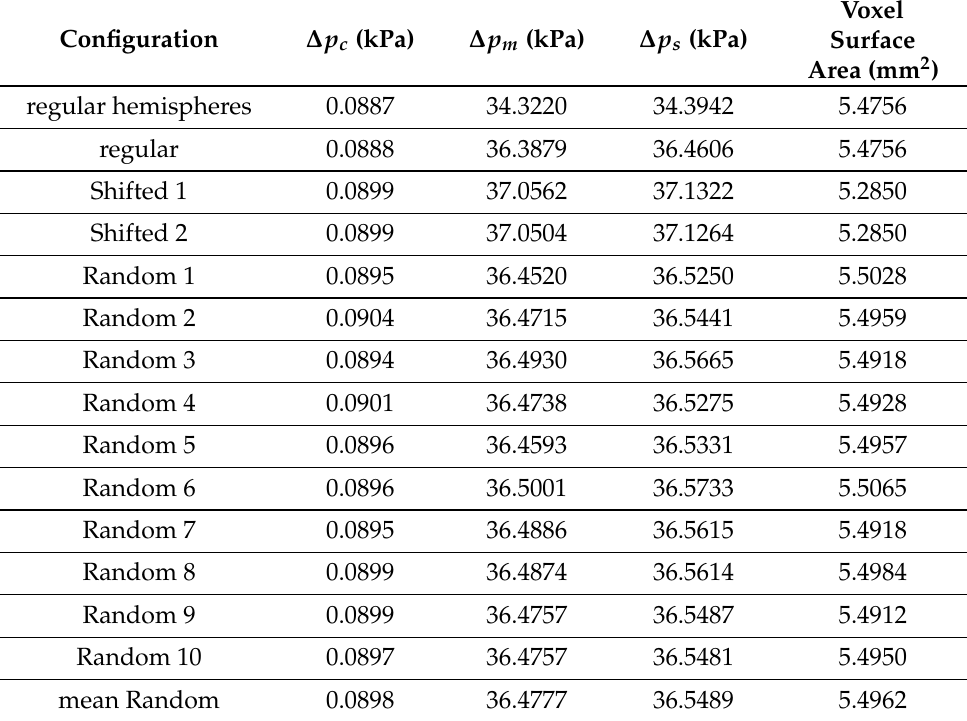
Table 4. Simulation results for adding microcapsules during the manufacturing